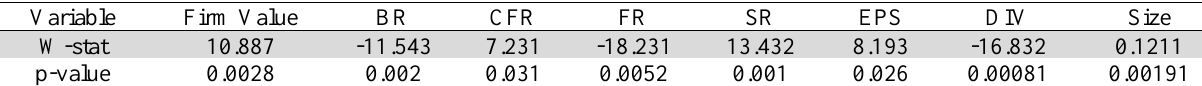
The summary of IPS